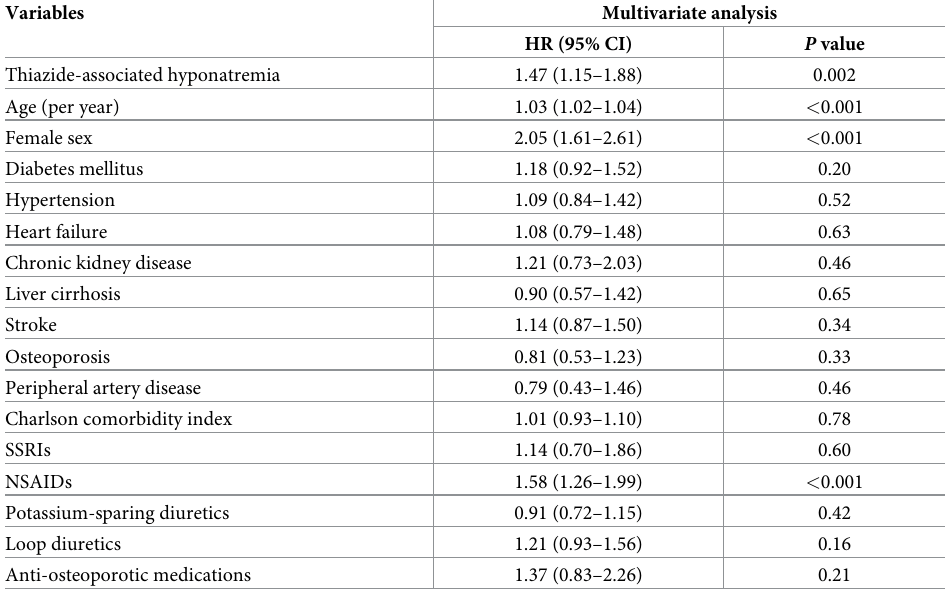
Table 4. Risk factors associated with fractures among all subjects by multivariable Cox regression